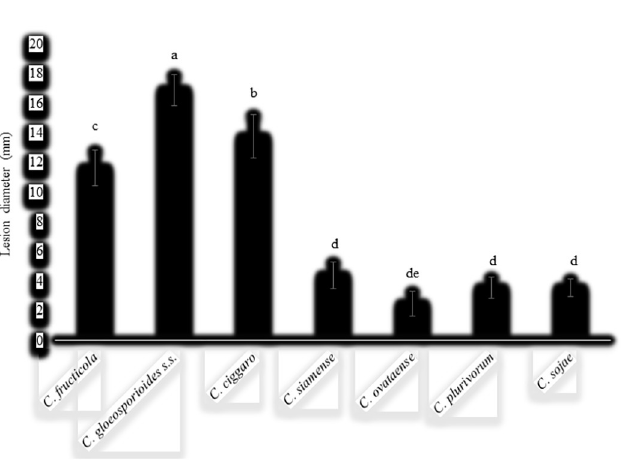
Fig 19. Lesion diameter on OLA leaves after wound-inoculation with different Colletotrichum species. Data were analyzed with SAS 9.4 by one-way ANOVA and means were compare using lsd test at the level of P = 0.05. Data (mean ± standard error) with different letters are significantly different at P < 0.05 (n = 12).